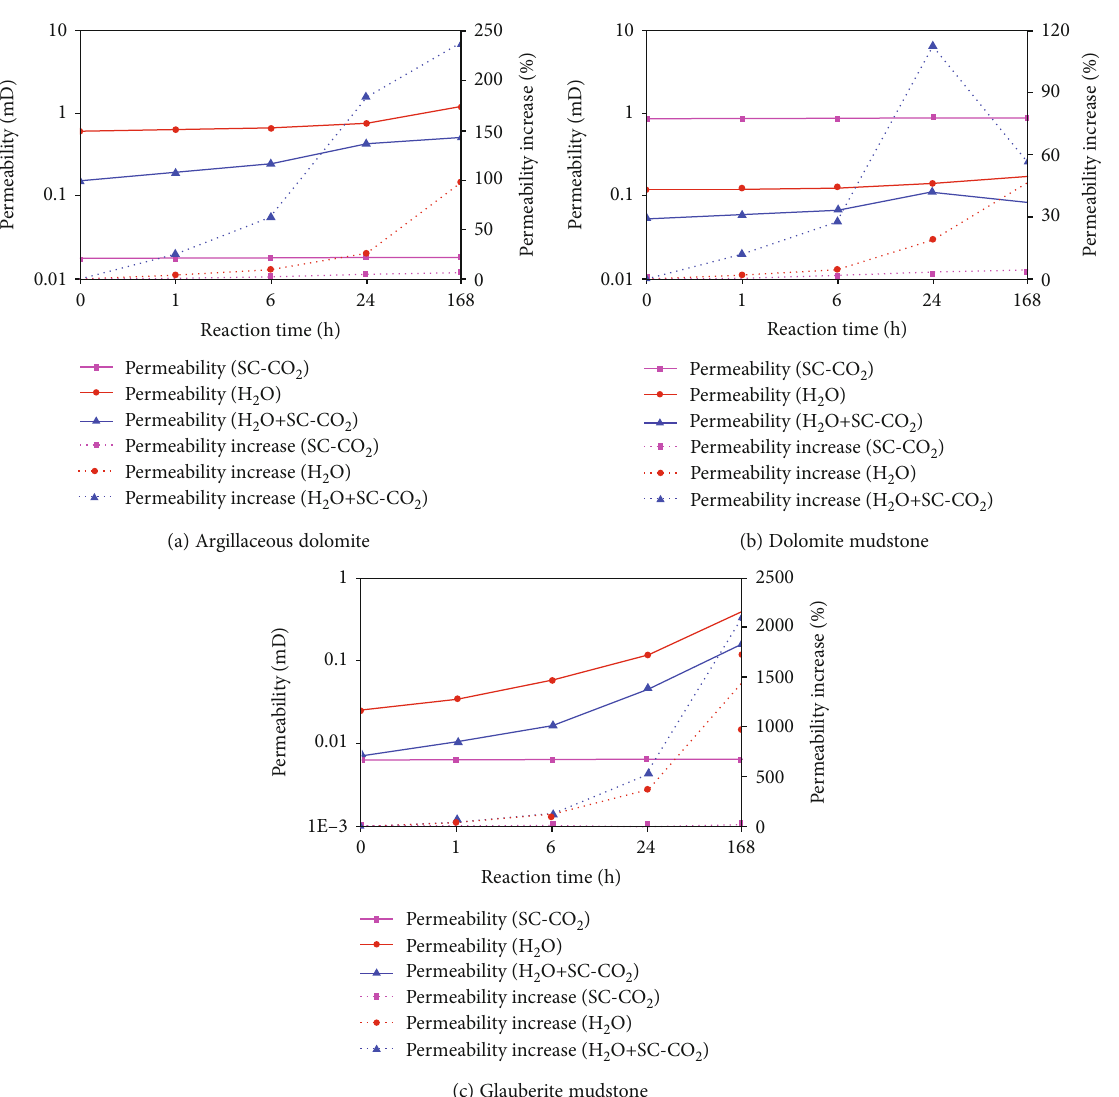
Figure 8: Change of permeability after immersion in fl uid at di ff erent